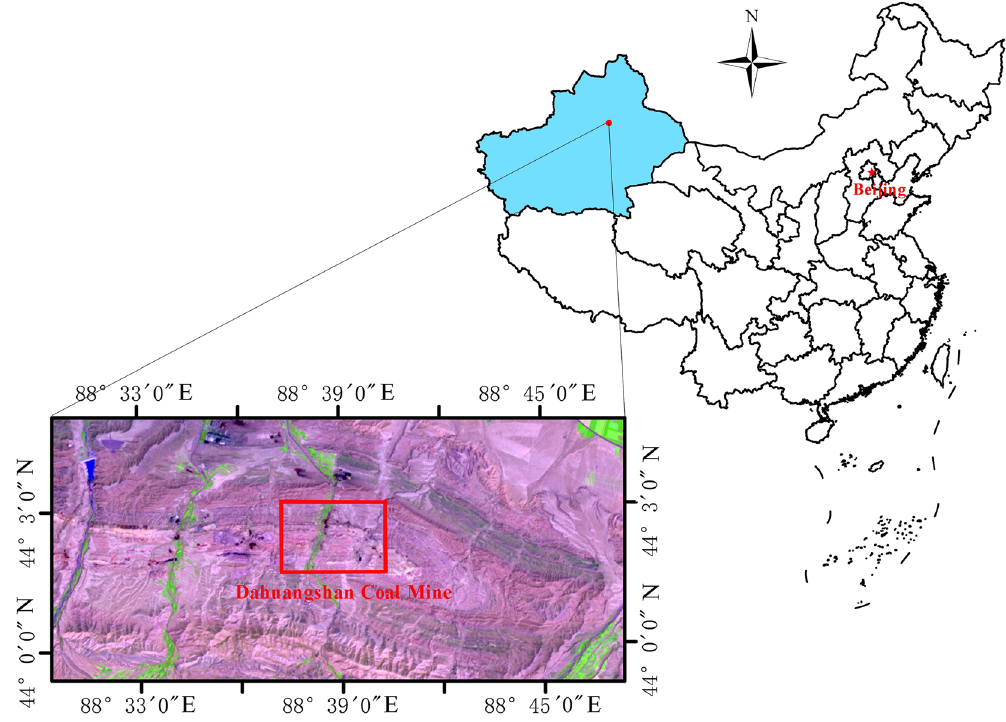
Figure 1. Location of the study